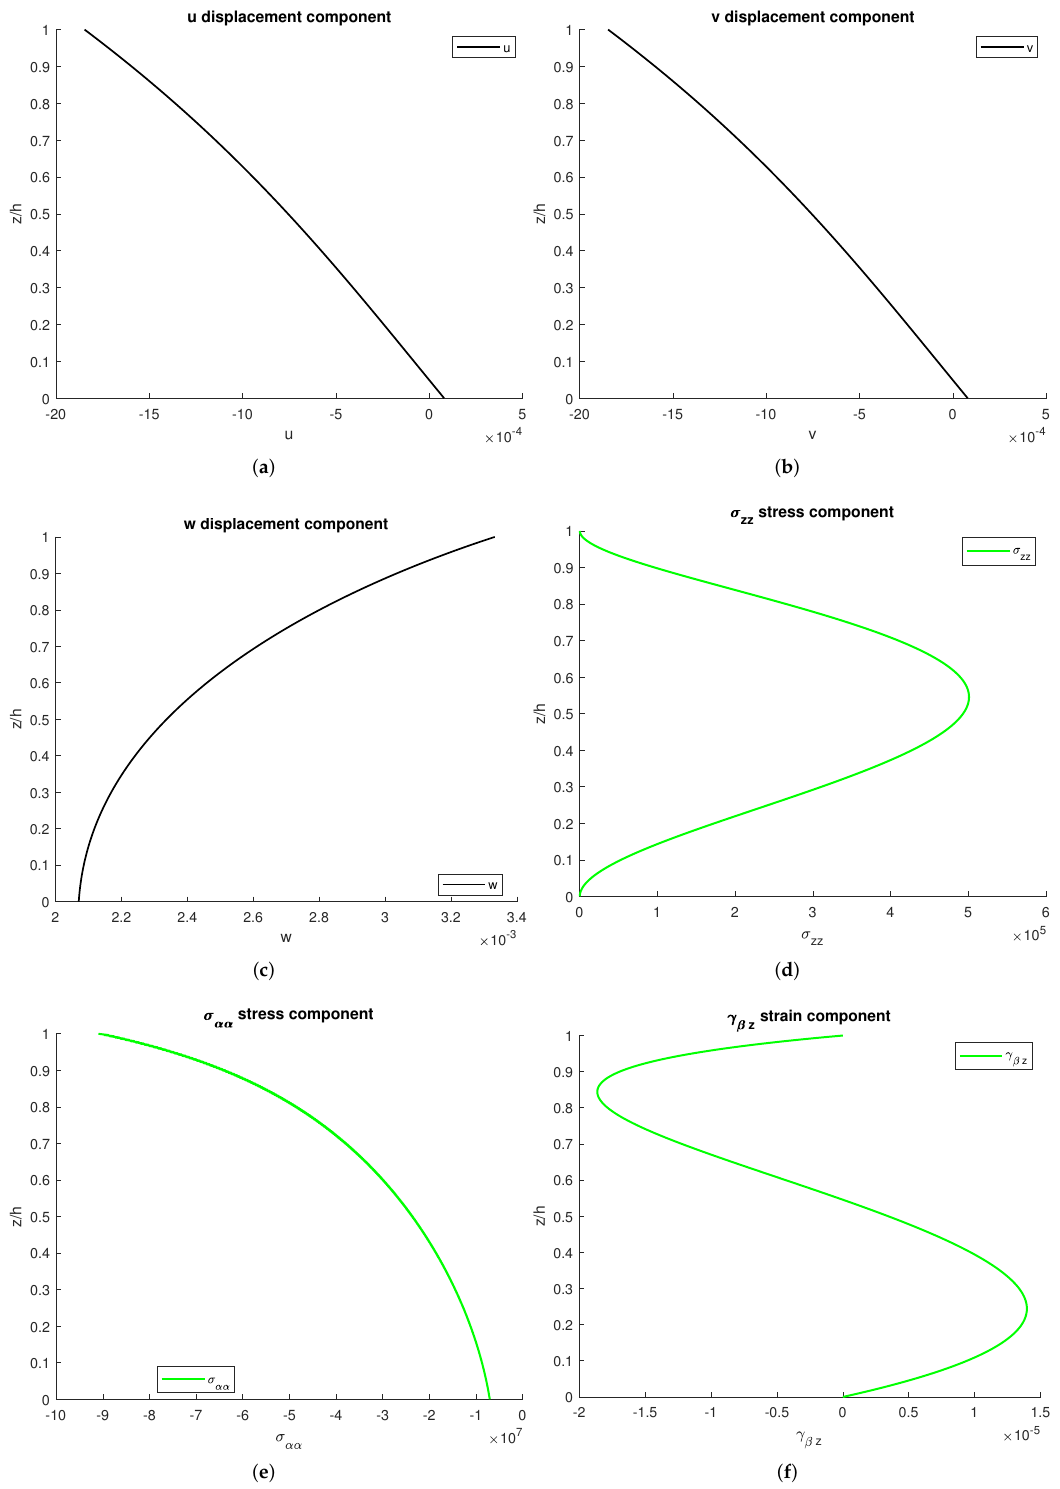
Figure 4. First benchmark: one-layered FGM square plate with an imposed moisture content on the top and bottom surfaces. The results are calculated for a moderately thick ( a / h = 4) structure via the 3D( M c ,3 D ) model. ( a ) Amplitude of u displacement component. ( b ) Amplitude of v displacement component. ( c ) Amplitude of w displacement component. ( d ) Amplitude of σ zz stress component. ( e ) Amplitude of σ αα stress component. ( f ) Amplitude of γ β z strain